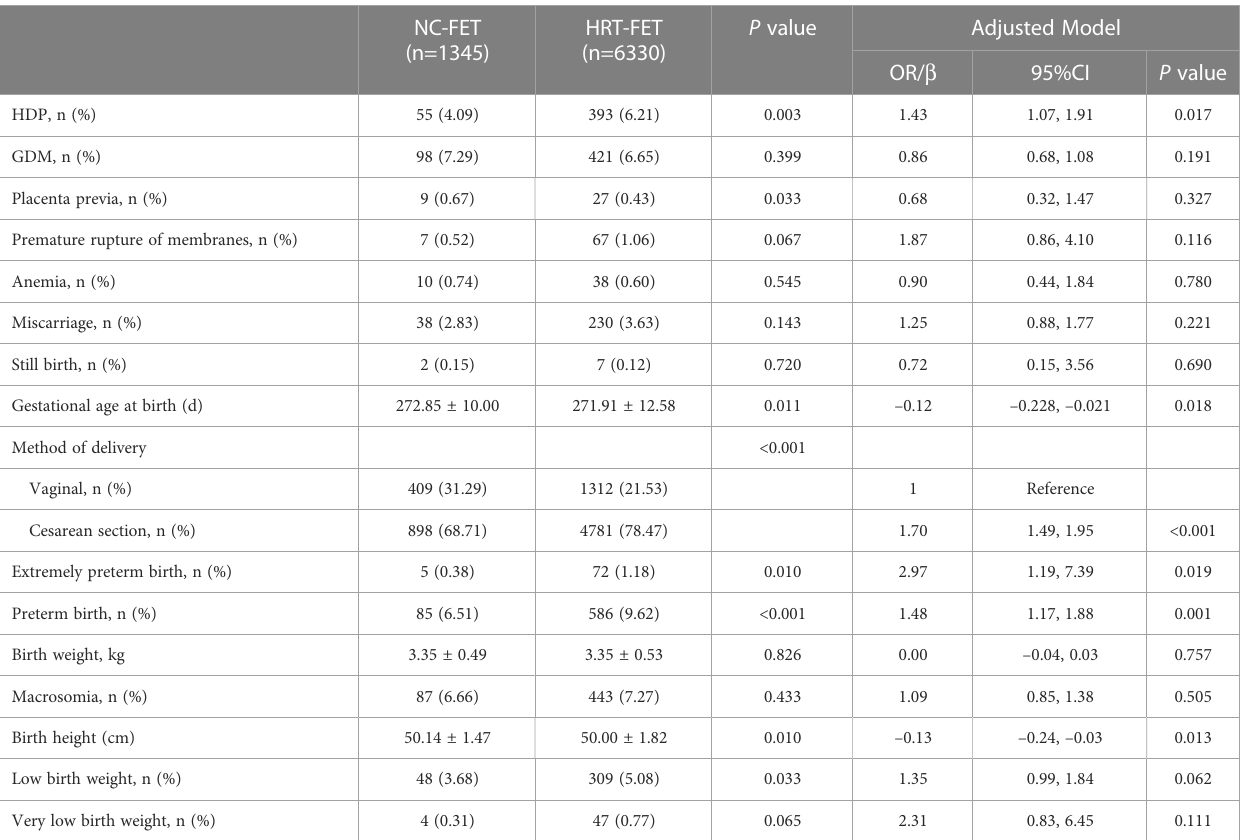
TABLE 2 Perinatal outcomes of singleton pregnancy after two different FET regimens.